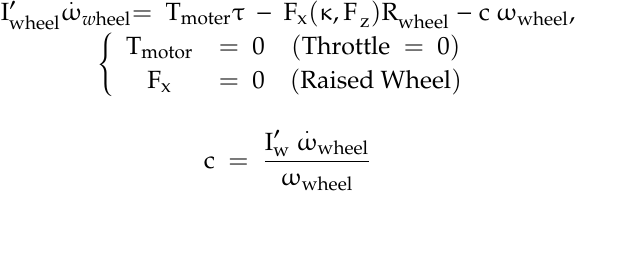
Table 1. Test bench model parameters and variables.